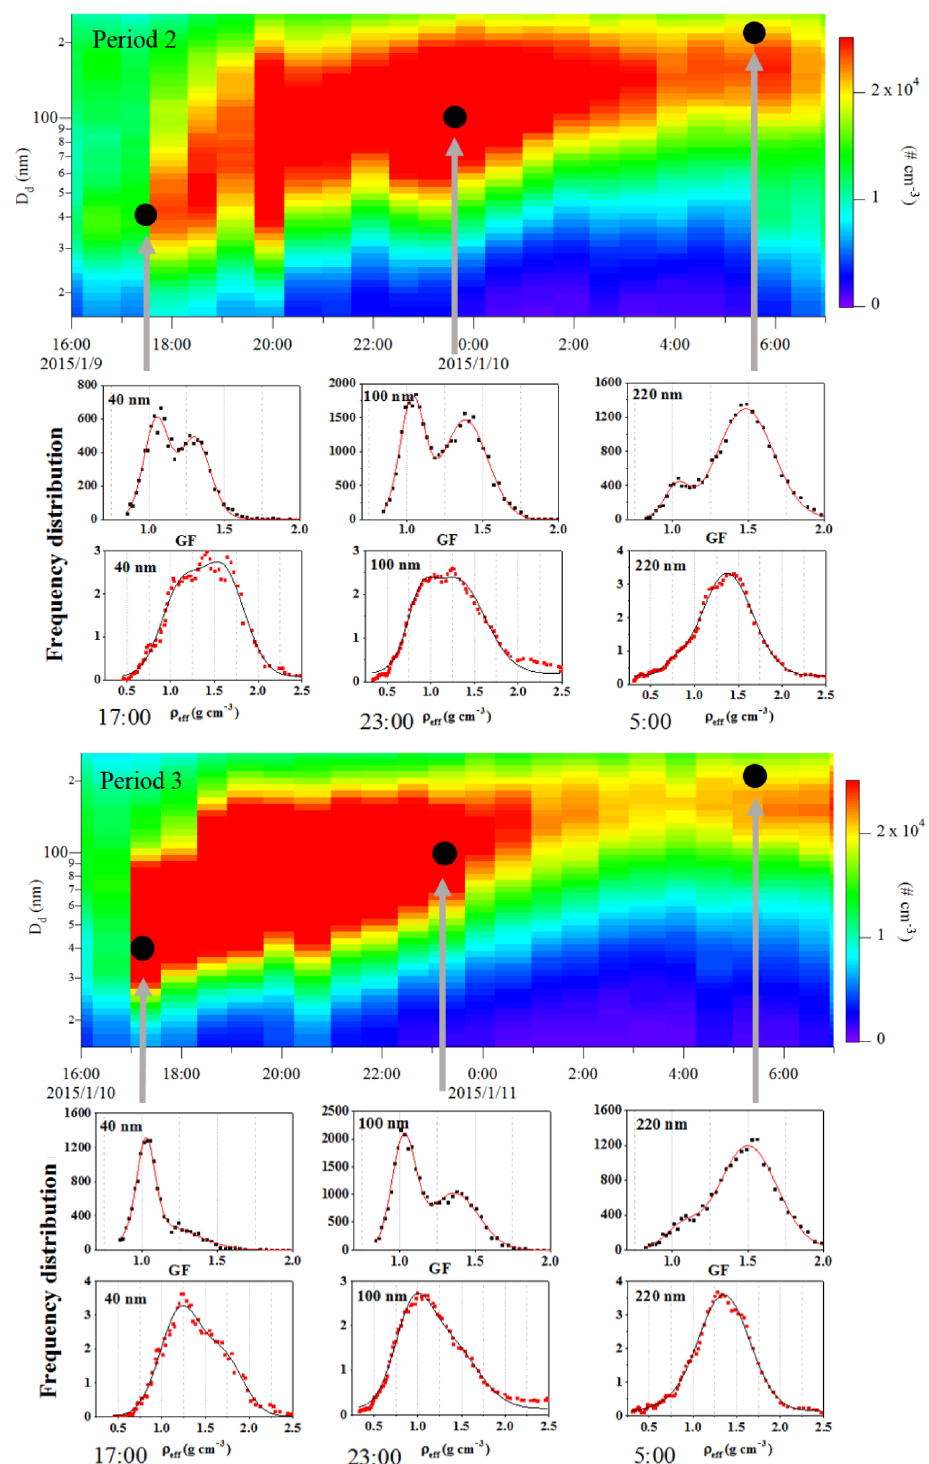
Figure 8. Particle hygroscopicity and density during the two particle growth